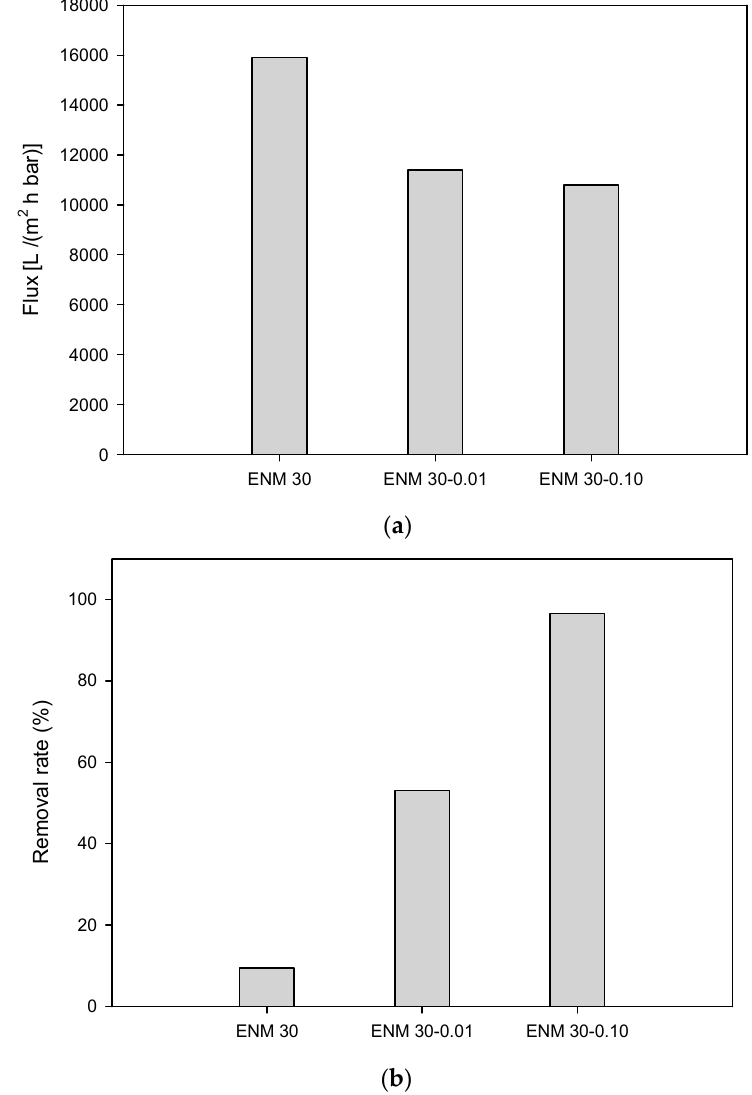
Figure 5. Water permeation ( a ) and 0.6 μ m PS suspension filtration ( b ) performance of the PES ENMs.